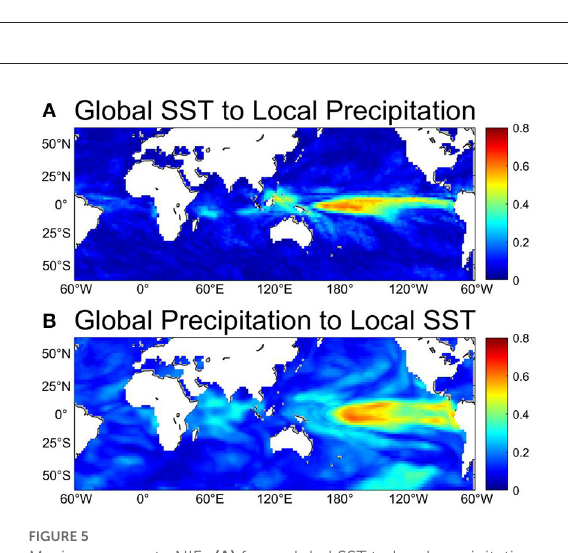
FIGURE4 Zonal average of NIFs at different latitudes. The red (blue) curve shows NIFs from precipitation (SST) to SST (precipitation). The meridional SST gradient (green) and the total precipitation (magenta) data is also shown. The meridional SST gradient and total precipitation are normalized to [0, 1] by x i − x min calculating y i . x max − x min =